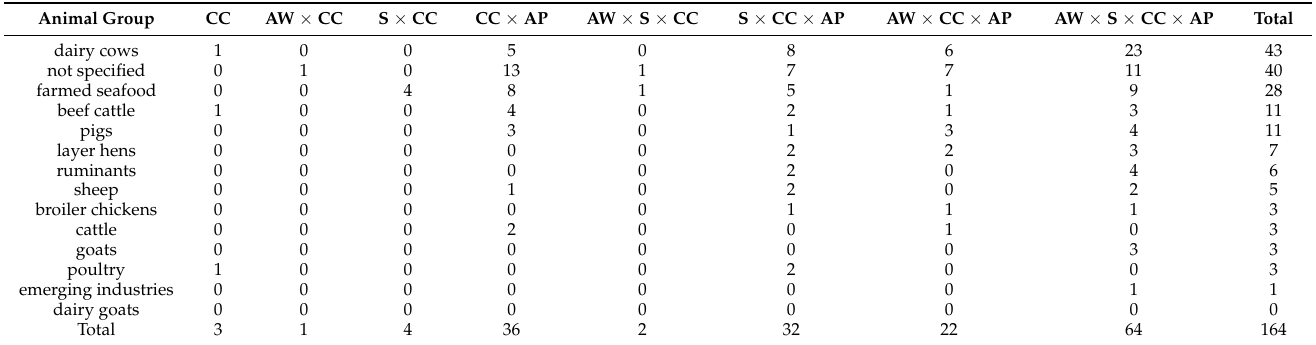
Table 6. Summary of articles discussing Climate Change—CC interaction with Animal Welfare (AW), Stress (S), Animal Production—AP) in their research between